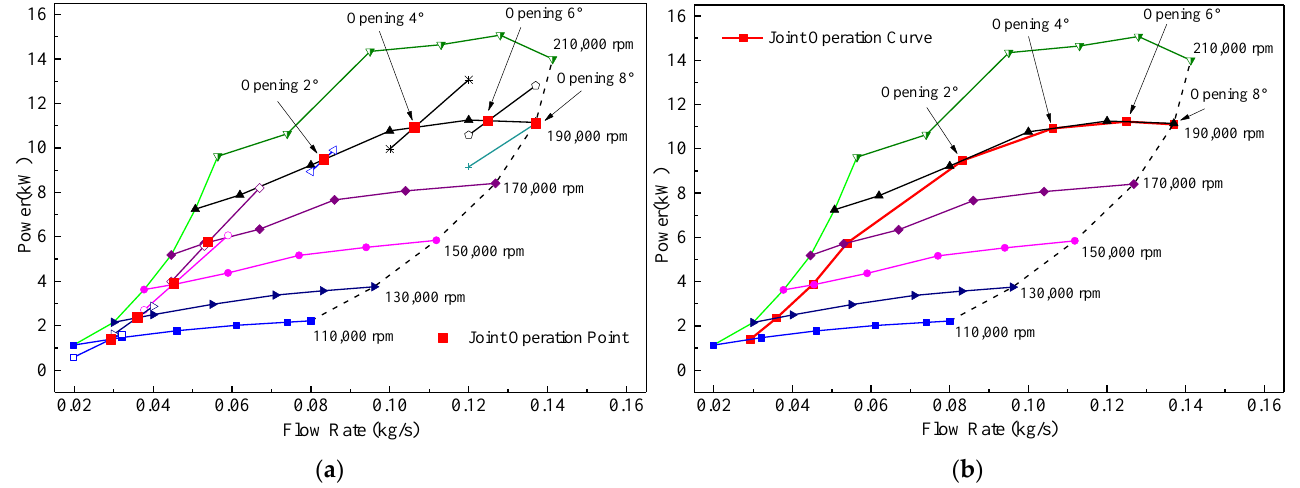
Figure 9. ( a ) The joint operating point when the bypass valve is open; ( b ) the internal joint operating curve when the bypass valve is open.